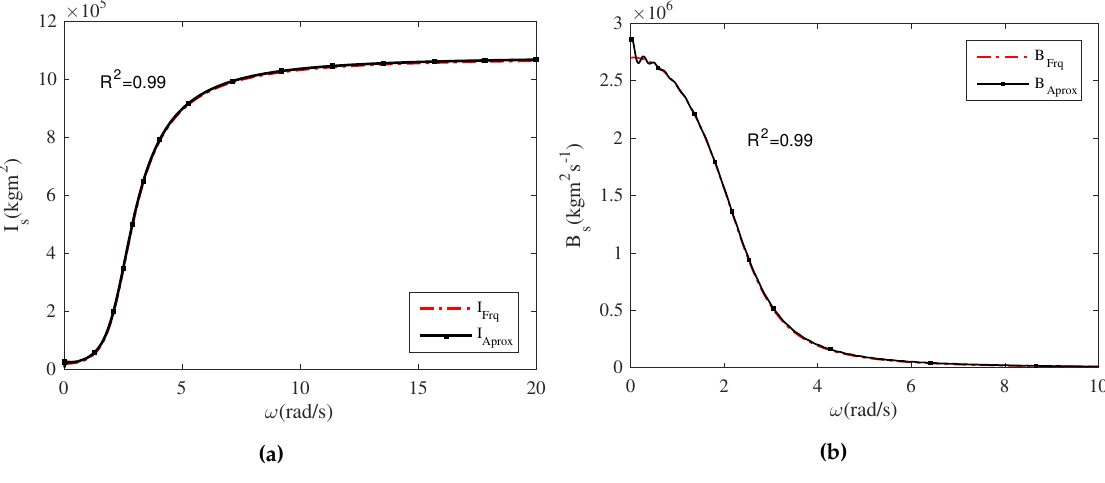
Figure 6. ( a ) Added mass ( I s ) vs. ω ; ( b ) Radiation damping ( B s ) vs. ω , indicates frequency domain data and transfer function approximation data (dashed red line; frequency domain data, solid line; transfer function approximation data).